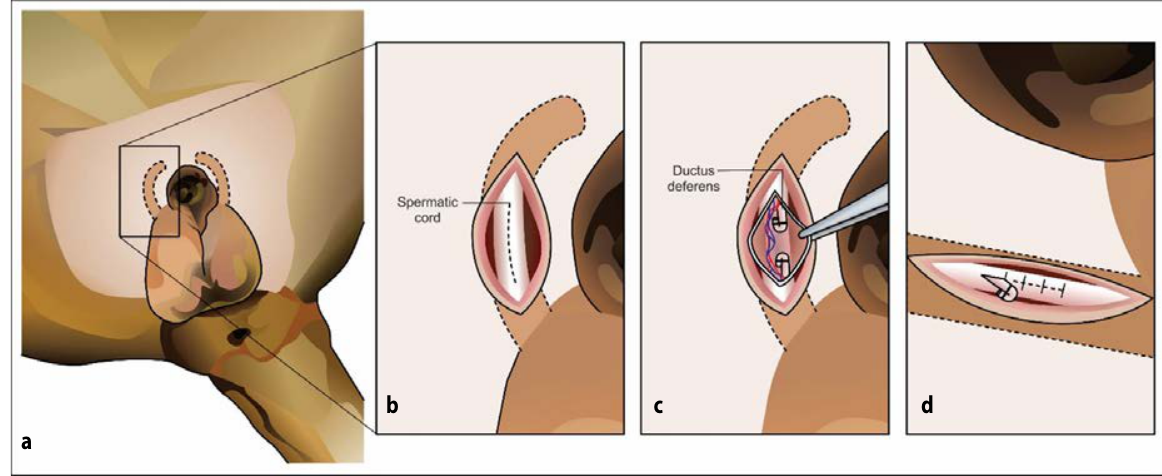
Figure 2: (a) Location of the spermatic cord – most easily accessed laterally of the penis; (b) After incision of the skin and subcutaneous tissues, the spermatic cord can be visualised; (c) After partial resection of the ductus deferens, both ends of the ductus deferens are folded and ligated using monofilament absorbable suture material; (d) The prostatic end of the ductus deference is left outside of the spermatic cord, after which the spermatic cord is closed; facilitating the fascial